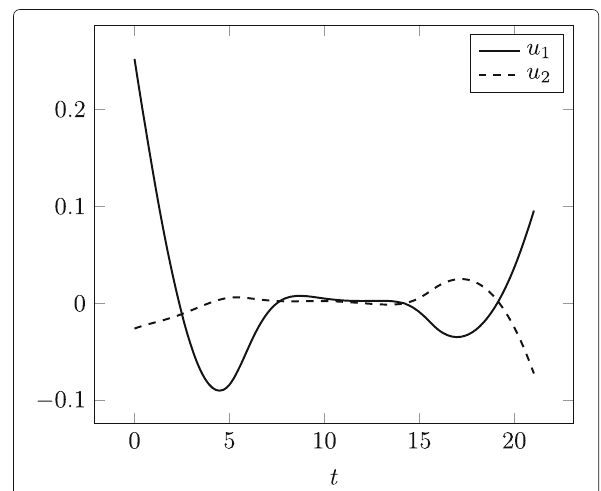
Fig. 18 Time history of control variable u ( t ) during the pull-up maneuver